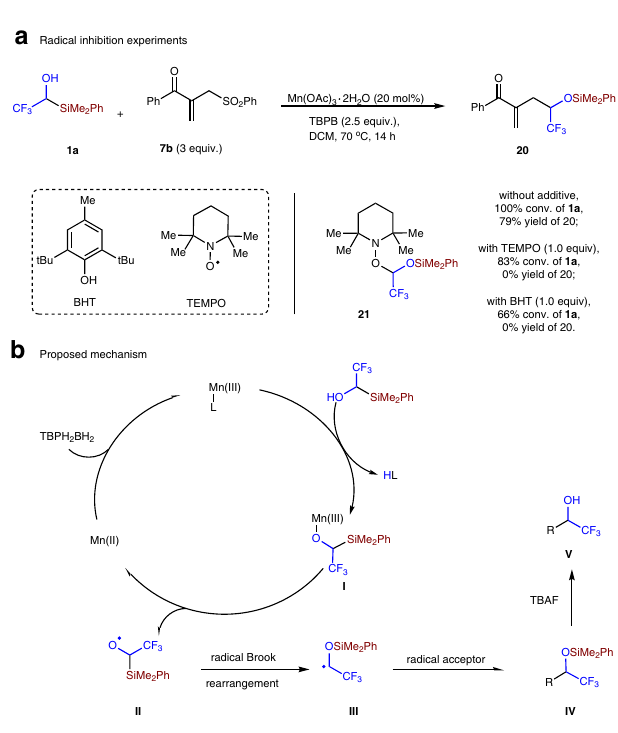
Fig. 9 Radical inhibition experiments and proposed mechanism. a TEMPO and BHT ef fi ciently inhibited the allylation reaction, supporting radical process might be involved. b A plausible mechanism is